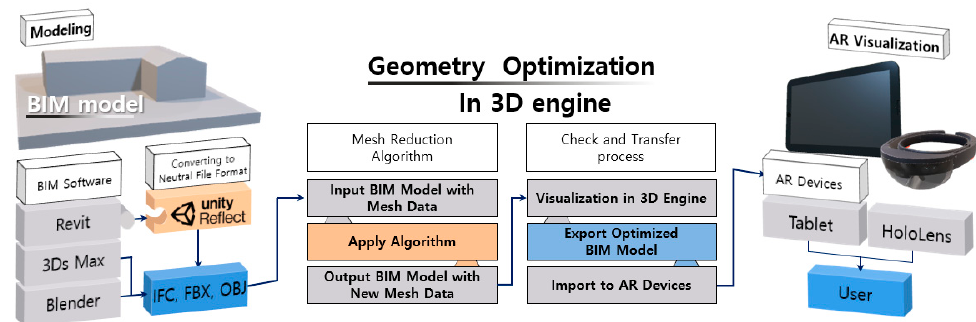
Figure 1. Conceptual framework of 3D engine-based geometry optimization for augmented reality (AR) visualization.